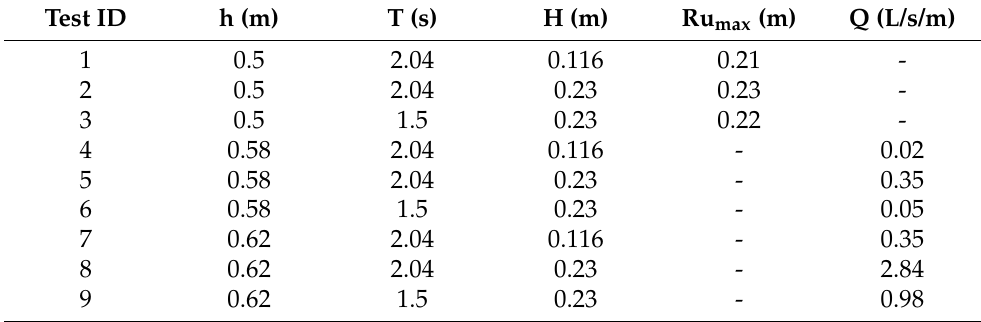
Table 2. Maximum run-up and mean wave overtopping discharge obtained in the